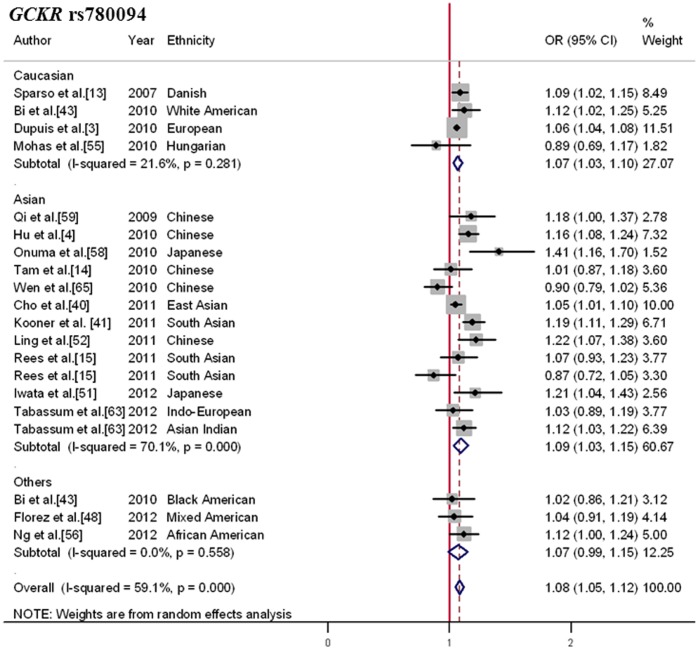
Forest plot for the association between GCKR rs780094 and T2DM.Pooled OR for the additive genetic model was shown under a random-effects model. Square sizes were proportional to weight of each study in the meta-analysis. Our meta-analyses demonstrated GCKR locus confers high cross-ethnicity risk for development of T2DM.